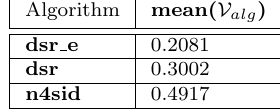
Table 1: Example 4.1. The table shows the mean of the criterion V (defined in Eq. (33)) for dsr e , dsr and n4sid based on random dis- crete space model Monte Carlo simulations.